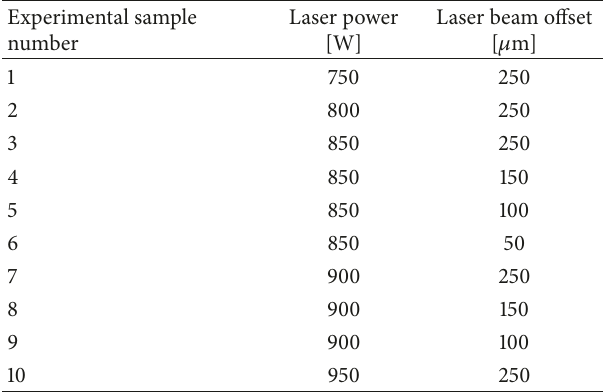
Table 3: Welding parameters applied for numerical experiments. Experimental sample